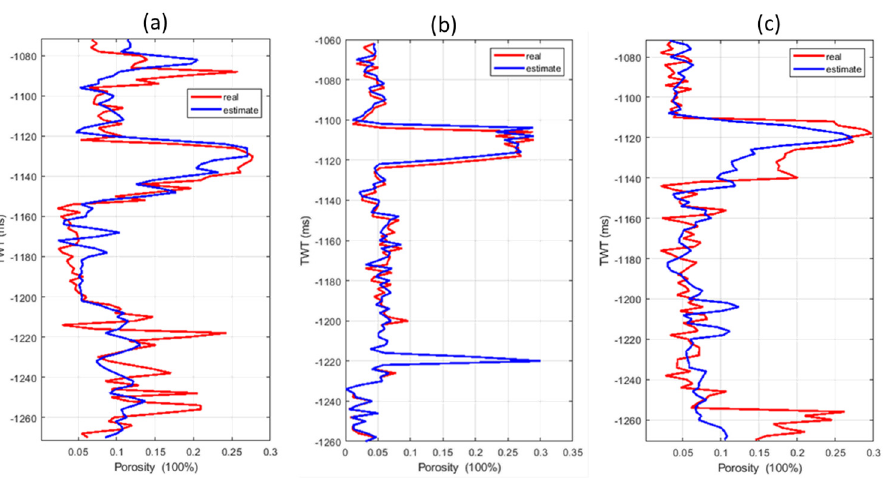
Figure 12. Porosity estimation at well location, ( a ) Well 3 (blind), ( b ) Well 1 (control) and ( c ) Well 2 (blind).